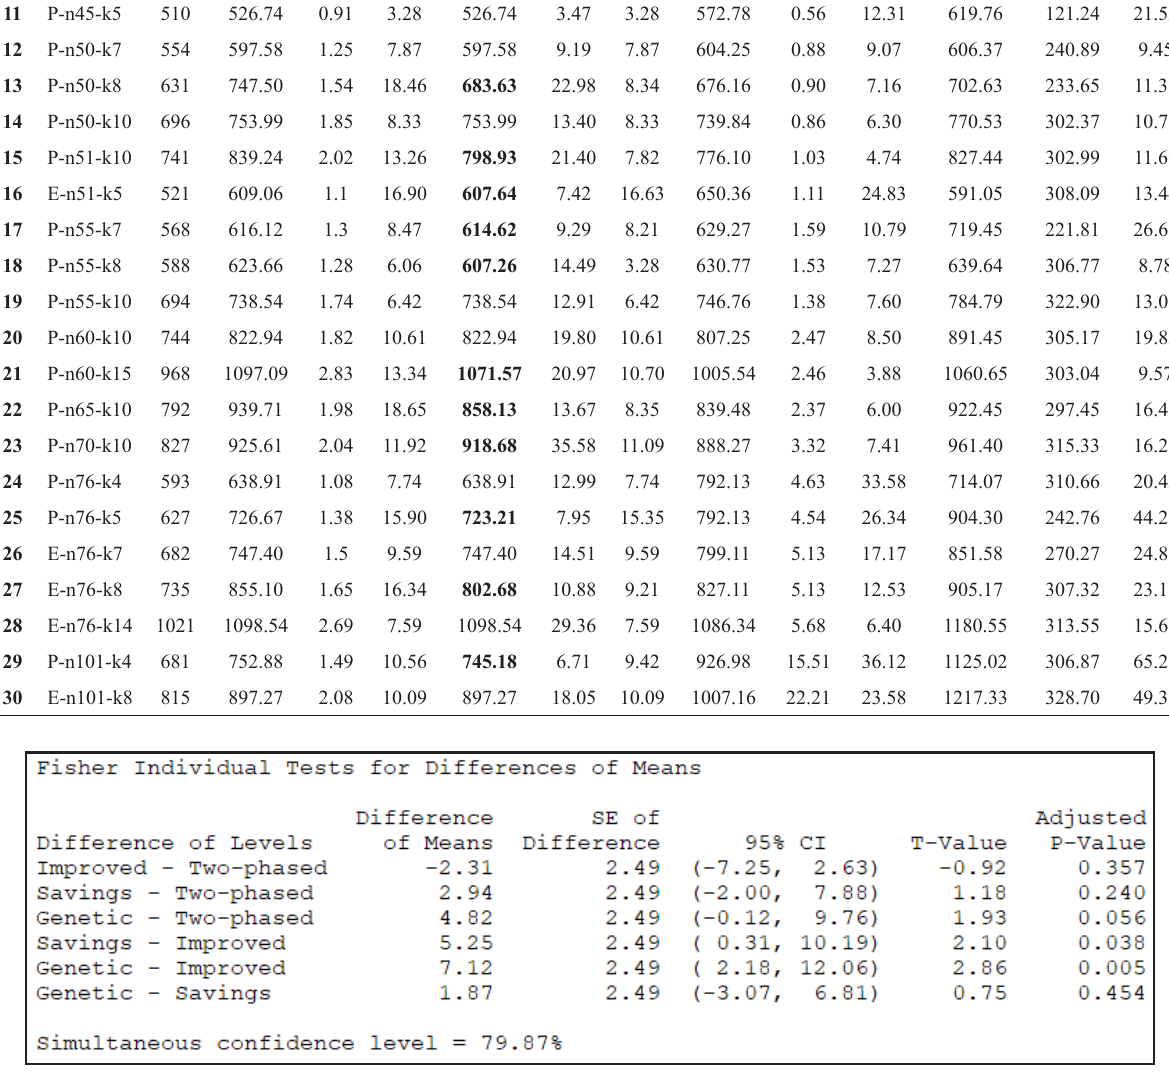
Figure 2: Results of the Fisher’s LSD